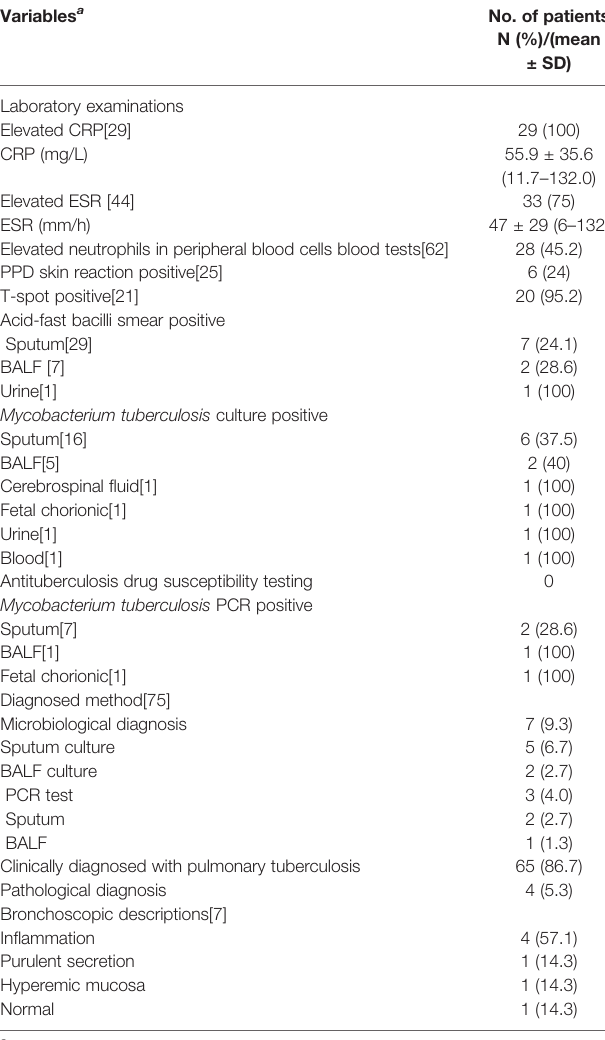
a Values in brackets represent number of patients for whom data were available. CRP, C-reactive protein; ERS, erythrocyte sedimentation rate; BALF, bronchoalveolar lavage fl uid; PCR, polymerase chain